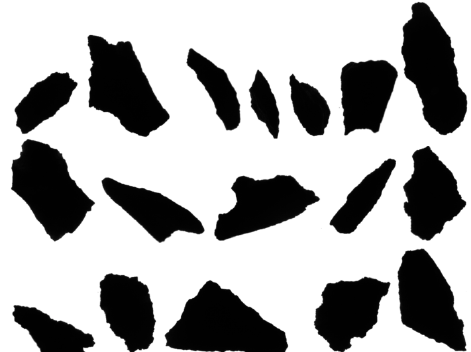
Figure 8. Irregular particles of chalcedonite feed in particle size fraction 6.3–8 mm.